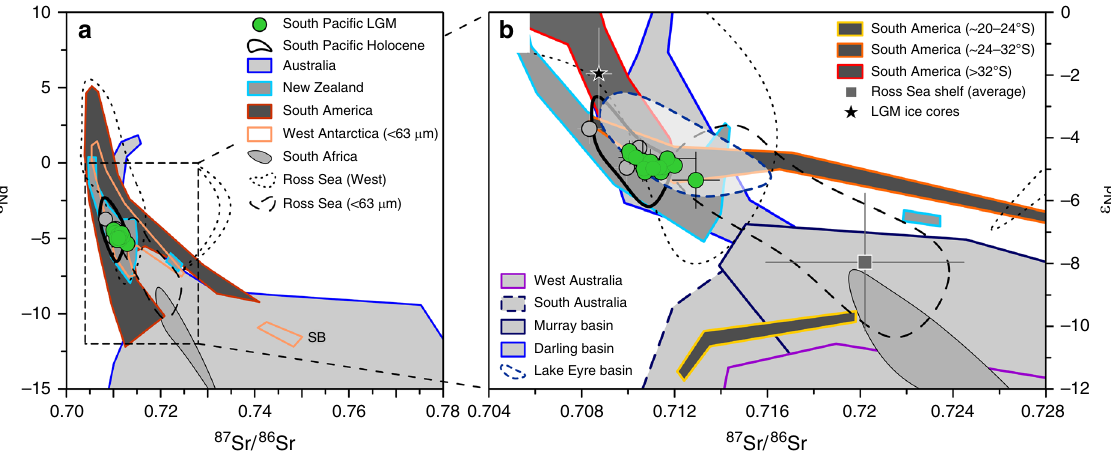
Fig. 2 South Paci fi c Last Glacial Maximum fi ne fraction samples in Nd-Sr isotope space. Remote open ocean samples in green and locations at/near the continental margins in gray. Last Glacial Maximum (LGM) data points and error bars represent averages and their 2 SD across the LGM interval (~18 ‒ 24 ka BP). See Supplementary Fig. 1 and Supplementary Tables 2 and 3 for details and references to terrestrial source area data. a Overview of potential source area compositions in the Southern Hemisphere. West Antarctic and Ross Sea shelf data obtained from < 63 µ m fractions 50,96 . SB: Sulzberger Bay. b Detailed view with South American and Australian source areas subdivided into individual provinces. Average values for Antarctic ice cores calculated from LGM age samples at Dome B and C ( ε Nd = − 2.0 ± 1.5, 87 Sr/ 86 Sr = 0.7087± 0.0006, 2 SD, n = 9) 31,44 . Ross Sea shelf average 96 is indicative of the composition of ice-rafted detritus exported into the South Paci fi c 47 . Note the isotopic difference of Southwest Paci fi c location PS75/091-3 relative to the remaining open ocean data (see Supplementary Note 5 and Supplementary Fig. 6 for further